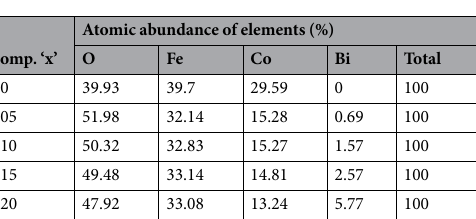
Table 2. The stoichiometry (%) of constituent elements present in CBF